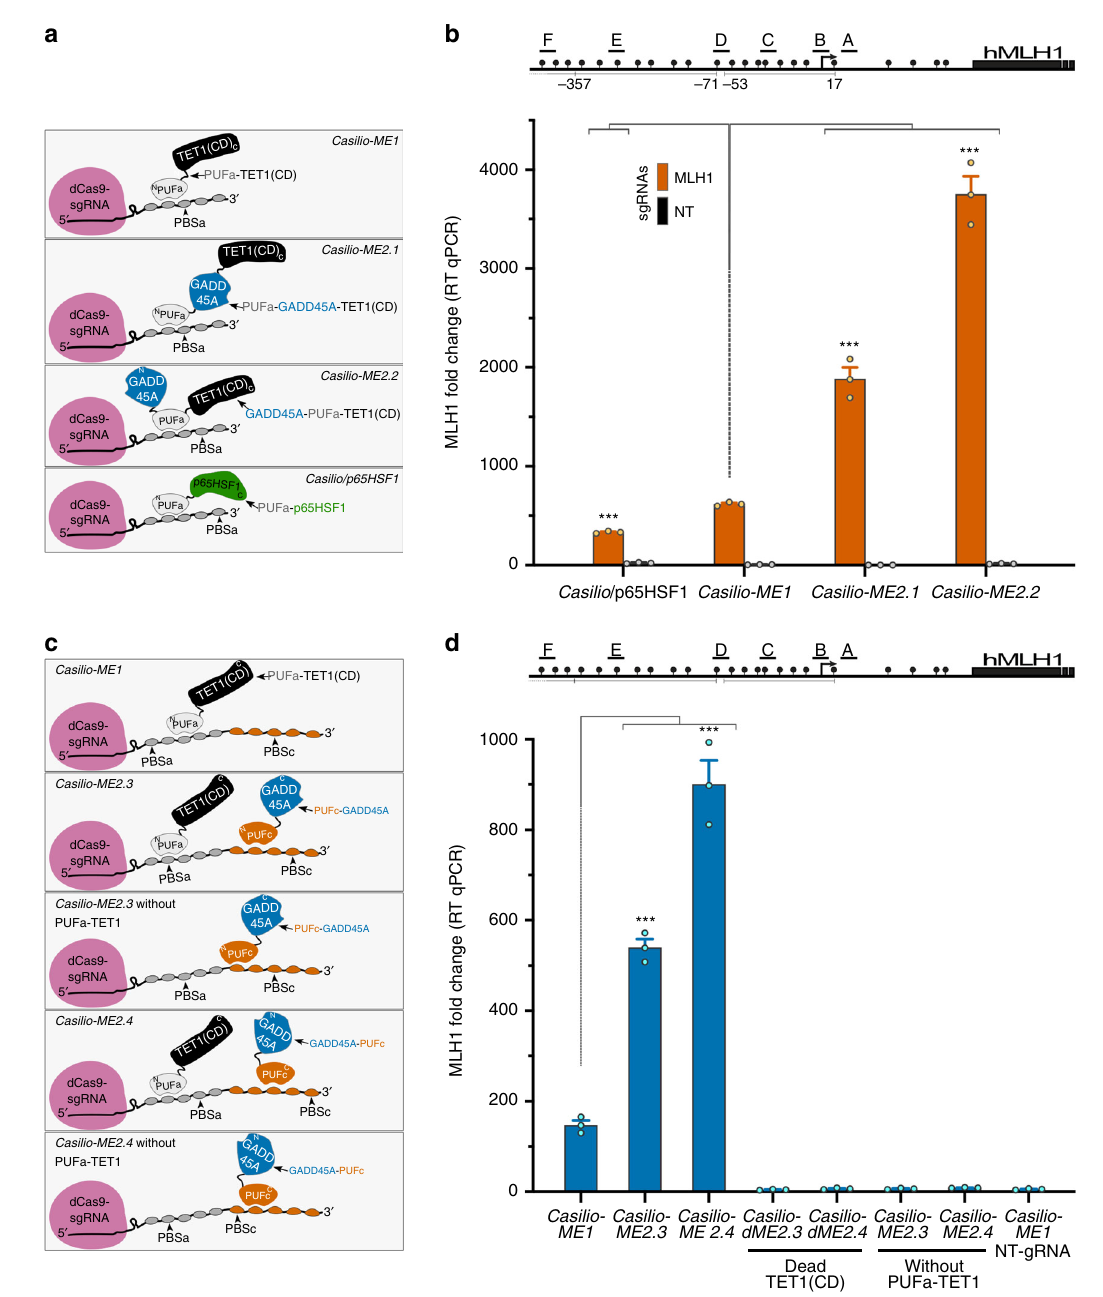
Fig. 2 Casilio-ME2 mediates dual delivery of TET1(CD) and GADD45A to targeted genomic sites. a Schematic representation of the indicated Casilio-ME and Casilio platforms showing effector modules of PUFa fusion proteins used to transfect cells analyzed in (b). TET1(CD) (black), GADD45A (blue), p65HSF1 (green), PUFa (light gray), amino (N), and carboxyl (C) termini of protein fusions and occupancy of PBSa are arbitrarily shown. b Plot showing MLH1 mRNA relative levels (mean fold change ± S.E.M.; n = 3) in cells transfected with components of Casilio-ME1, Casilio-ME2.1, Casilio-ME2.2, or Casilio/p65HSF1 in the presence of MLH1 -sgRNAs or NT-sgRNA as indicated. Cells were collected 3 days after transfection. Drawing of promoter regions with the MLH1 -sgRNAs used (A-F), CpGs (lollipops), and TSS (arrow) is shown above the plot. *** p < 0.0005, one-way ANOVA. c Schematic representation of the indicated Casilio-ME platforms showing effector modules of PUFa and PUFc fusion proteins used to transfect cells analyzed in panel (d). TET1(CD) (black), GADD45A (blue), PUFa (light gray), PUFc (orange), sgRNA containing both PBSa and PBSc, amino (N) and carboxyl (C) termini of protein fusions are arbitrarily shown. d MLH1 mRNA relative levels (mean fold change ± S.E.M.; n = 3) in cells transfected with components of Casilio-ME1, Casilio-ME2.3, or Casilio-ME2.4 in the presence of MLH1 -sgRNAs or NT-sgRNA is shown. When indicated PUFa-TET1(CD), effector component of Casilio-ME2.3 and Casilio- ME2.4 , was replaced by a catalytically dead PUFa-TET1(CD) effector containing TET1-inactivating mutations H1671Y, D1673A 57 , or omitted. MLH1 promoter with the sgRNAs used (A-F), CpGs (lollipops), and TSS (arrow) is depicted above the plot. *** p < 0.0005, one-way